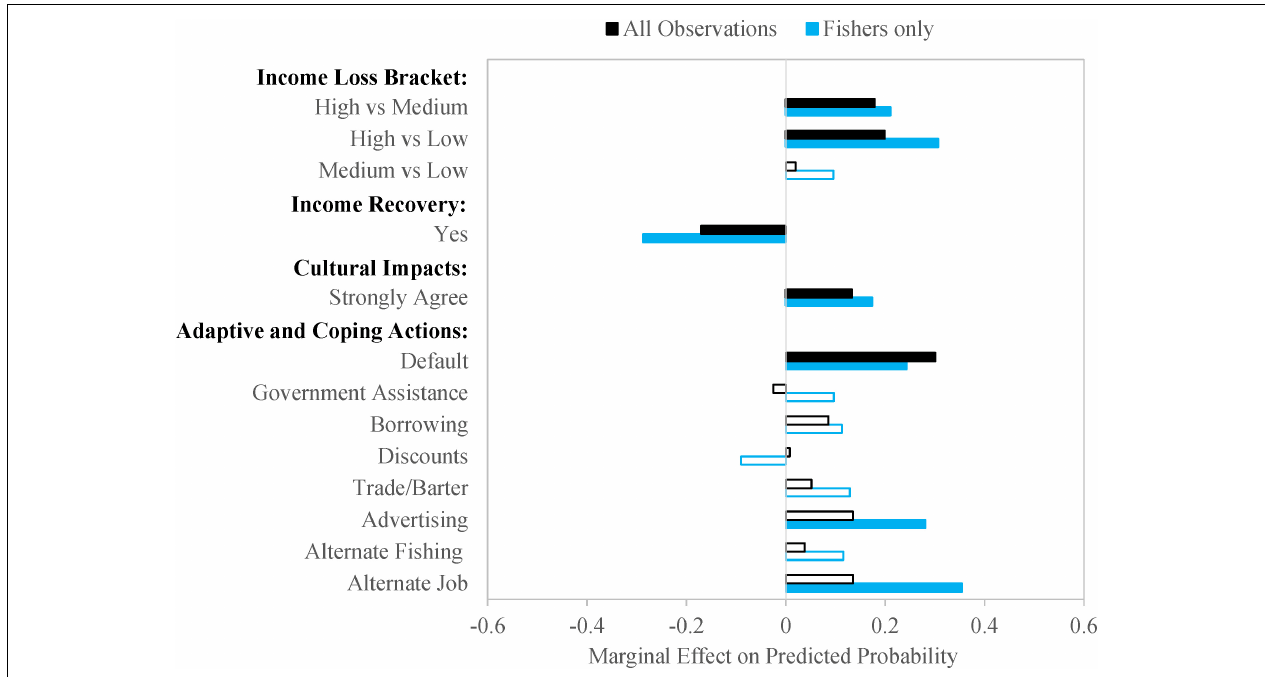
FIGURE 4 | The effect of income loss level, income loss recovery, cultural impacts, and adaptive and coping actions on the probability of strongly agreeing to experiencing stress. Statistically significant ( p < 0.1) effects are illustrated with solid bars while hollow bars represent statistically insignificant